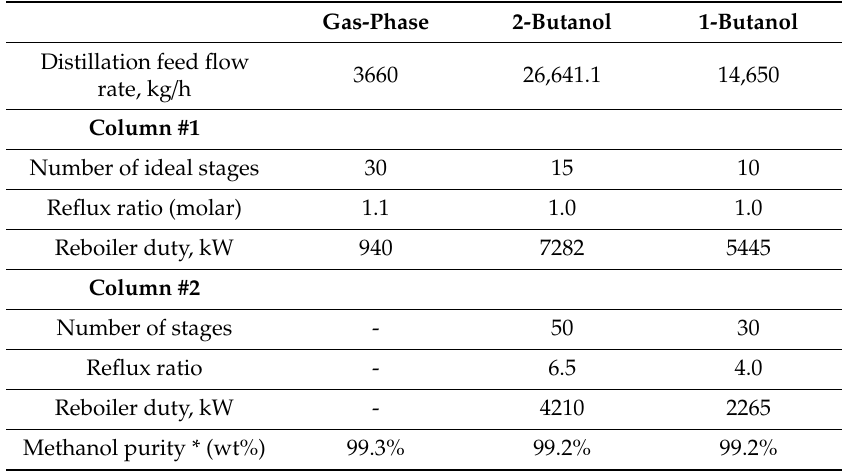
Figure 3. Flowsheet of the liquid-phase CO 2 hydrogenation to methanol process with 1-butanol solvent. The corresponding stream table is presented in Table S2. 1. Hydrogen inlet, 3. CO 2 inlet, 22. purge from gas recycle, 32. methanol product outlet, 33. gas purge from final flash tank. 34. waste water outlet, 37. purge from solvent recycle, 40. solvent make-up. Table 3. Distillation specifications and performance in the alternative methanol synthesis